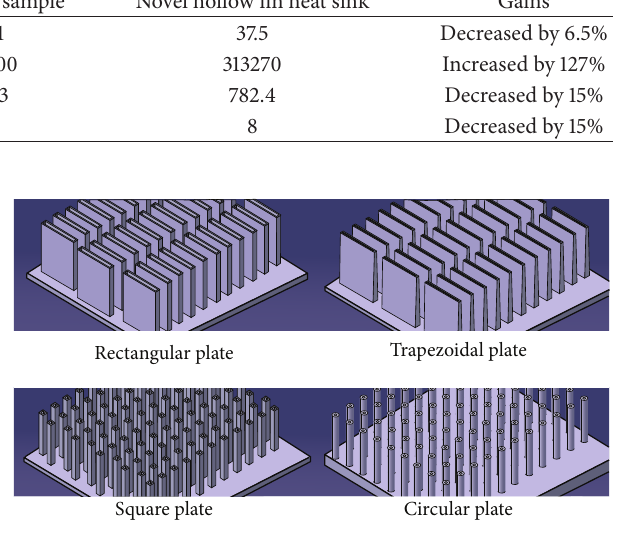
Figure 2: Types of hollow fin heat